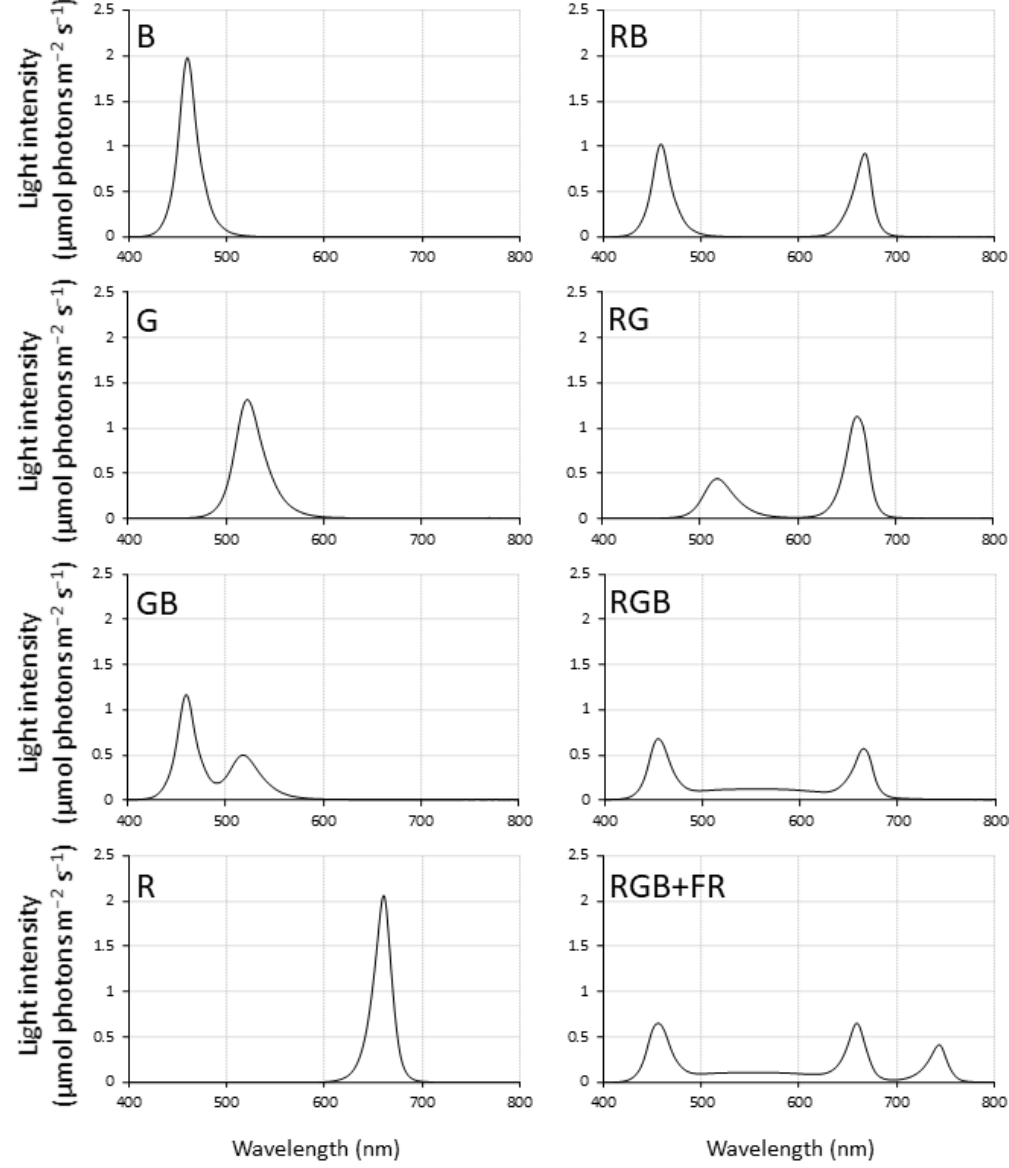
Figure 6. Light treatment spectra: monochromatic blue (B), monochromatic green (G), monochromatic red (R), green–blue (GB), red–blue (RB), red–green (RG), red–green–blue (RGB), and red–green–blue with far red (RGB + FR). Table 5. Yield photon flux (YPF) and photostationary state of phytochrome (PSS) for each light treatment.